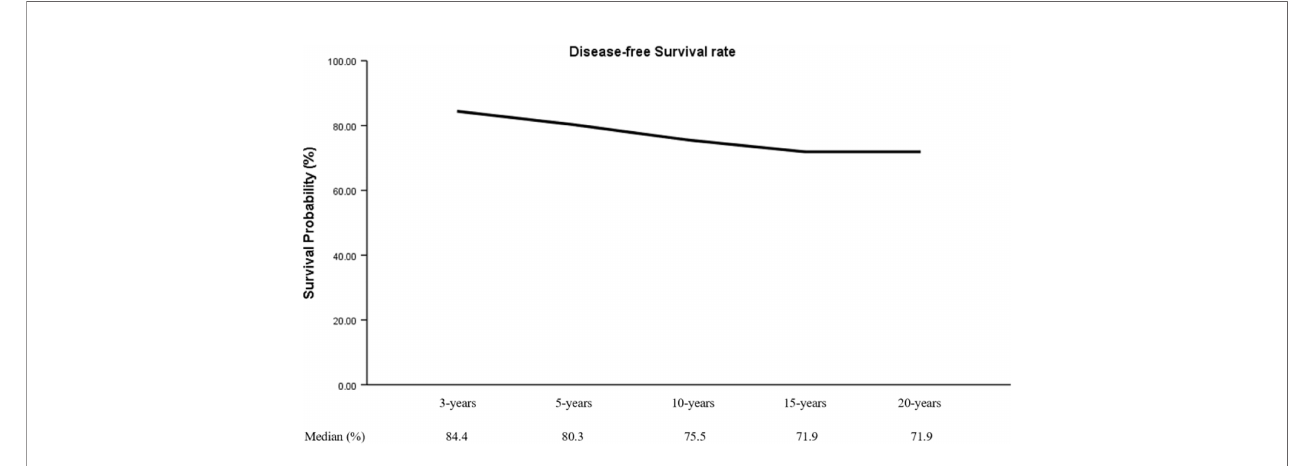
FIGURE 1 | Tendency chart of pooled